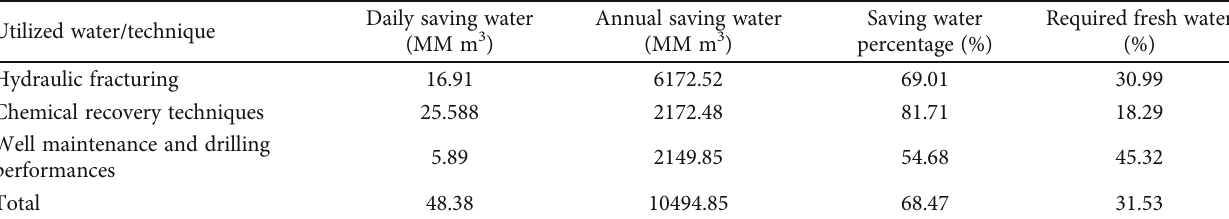
Table 5: Daily and annual saving water for the studied fi eld.